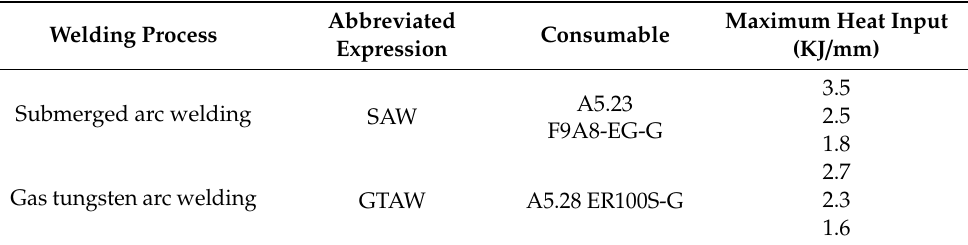
Figure 6. Schematic illustration of welding test plate. Table 2. Welding conditions.